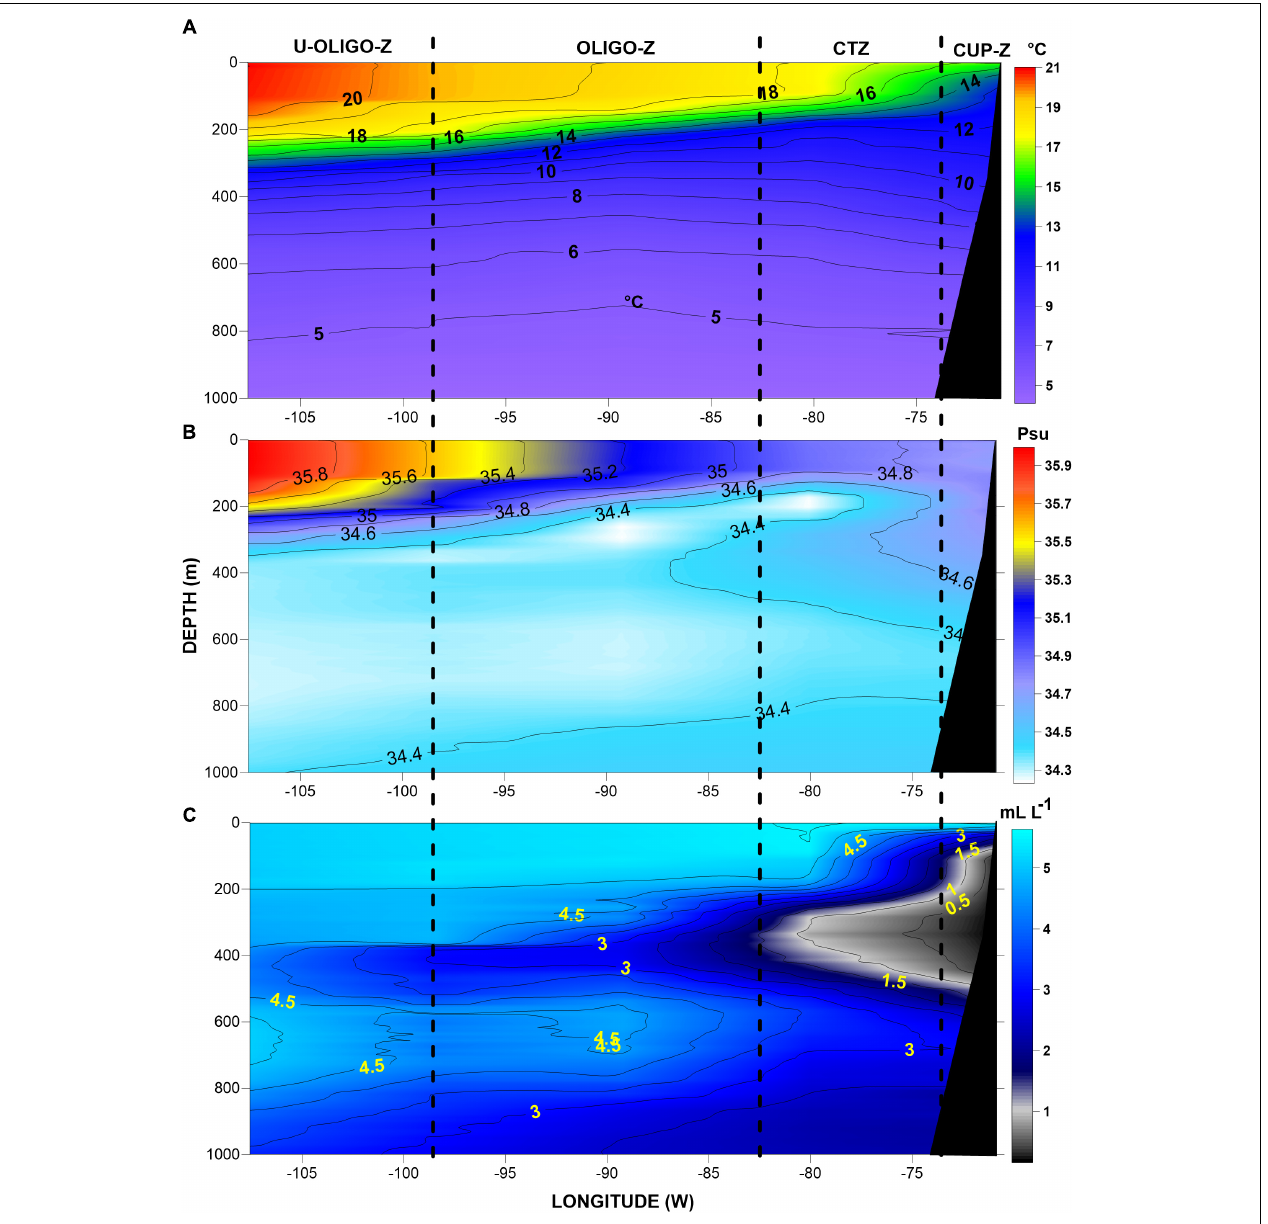
FIGURE 2 | Hydrographic conditions of the water column across the zonal gradient from the Chilean coast to Easter Island from CTDO profiles to 1,000 m: (A) temperature, (B) salinity and (C) dissolved oxygen (mL L − 1 ).